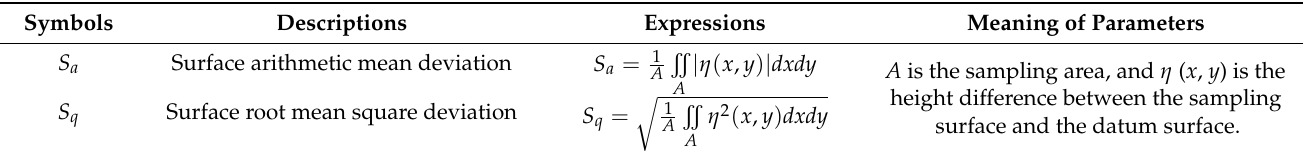
Figure 5. Schematic diagram of 3D surface roughness of body surface. Table 3. Three-dimensional surface roughness parameters.